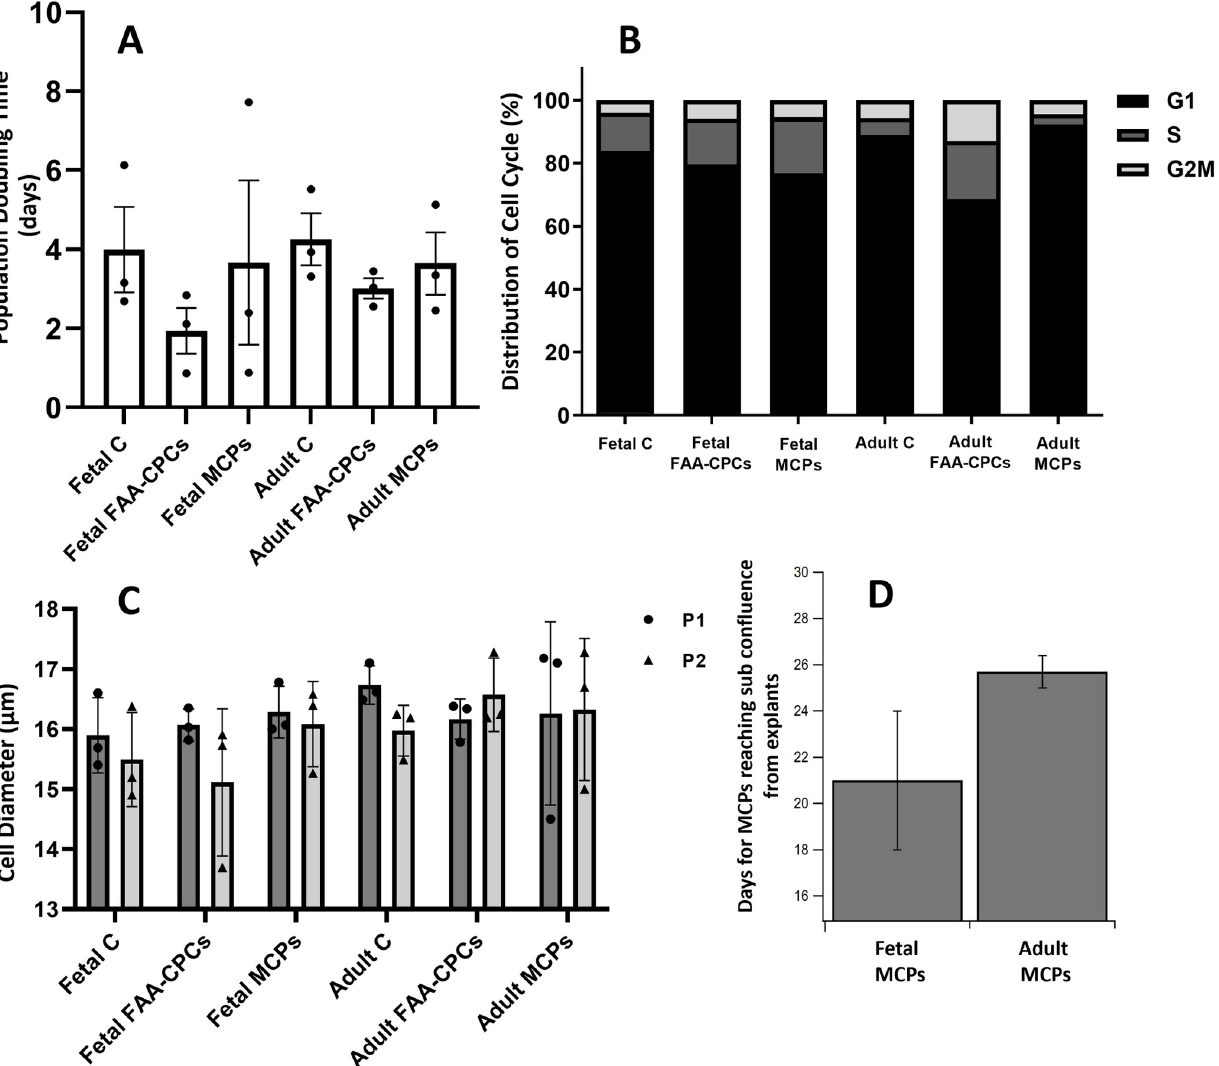
Fig 3. Population doubling time, cell diameter and cell cycle analysis. A) Analysis of the Population Doubling Time at passage 1 between the six groups displaying similar values with no significant difference. B) Analysis of the different phases in cell cycle distribution between the groups showed that adult FAA-CPCs that received exogenous growth factors and all three fetal groups and displayed greater proliferative capacity and higher levels of the S phase. C) Comparison of the cell diameter of the trypsinized cells at sub confluence, at passage 1 and 2 showed comparable dimensions. D) The average time in days for migration of MCPs from their explants to reach a confluence of 80% was shorter for Fetal MCPs, though their extracellular matrix displayed a dense matrix network when compared to adult cartilage.